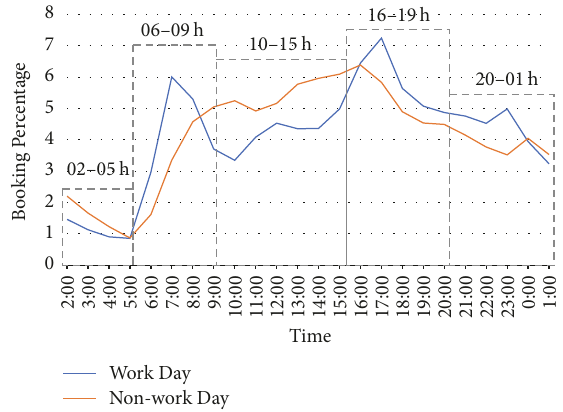
Figure 2: EVCARD trip temporal distribution and time